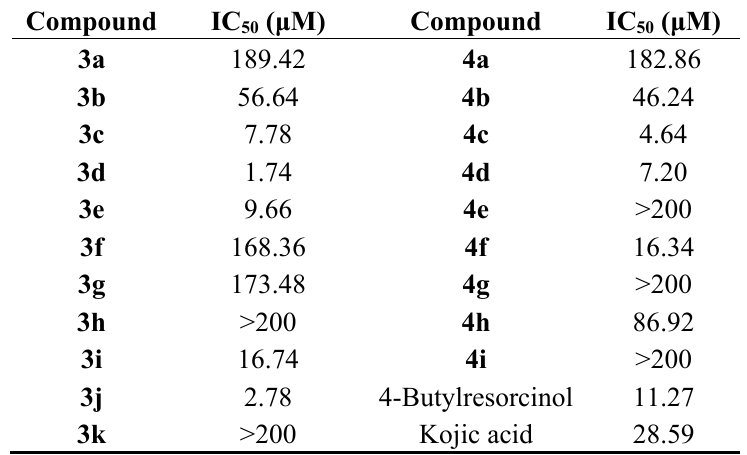
Table 1. Inhibitory effects of UCAs against mushroom